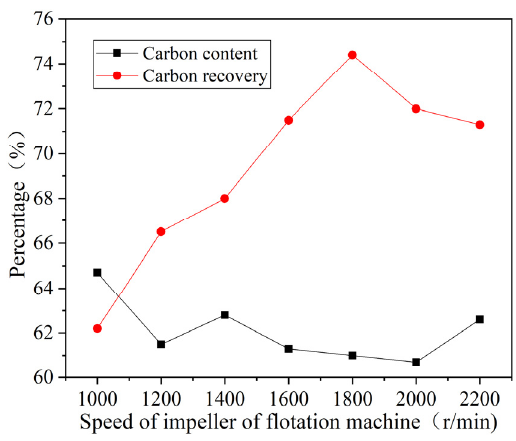
Figure 8. The effects of impeller speed on flotation.